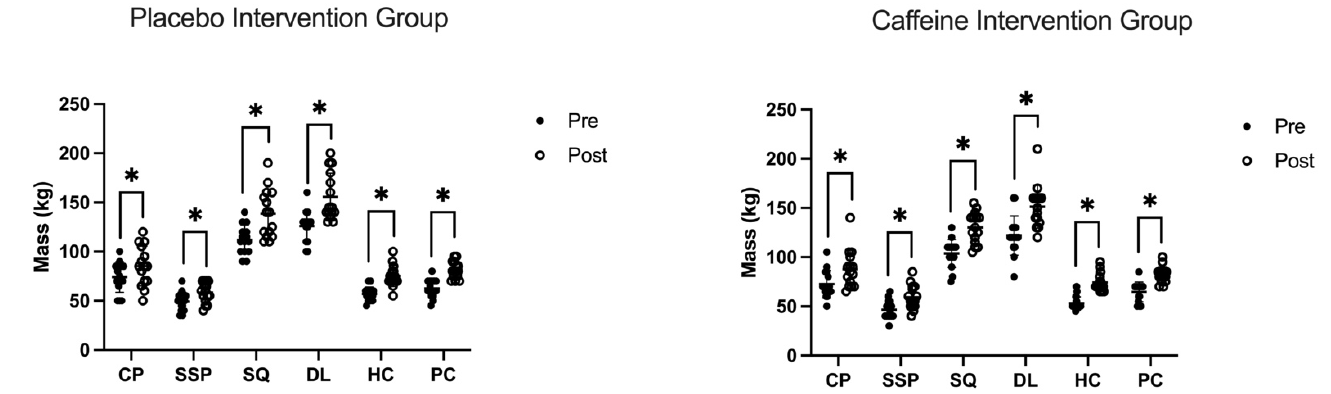
Figure 4. Effect of caffeine treatment (3 mg · kg − 1 ) pre and post-7-week resistance training program on pre-intervention 1RM and post-intervention 1RM, * represents a significant increase in performance post exercise intervention. The post intervention increase in 1RM was 16% and 16% CP; 19% and 22% SSP; 24% and 25% SQ; 24% and 24% DL; 42% and 40% HC; 30% and 27% PC for the placebo intervention group and caffeine intervention group, respectively. There was no main effect of intervention group for each exercise ( p > 0.850) other than the DL ( p = 0.001).